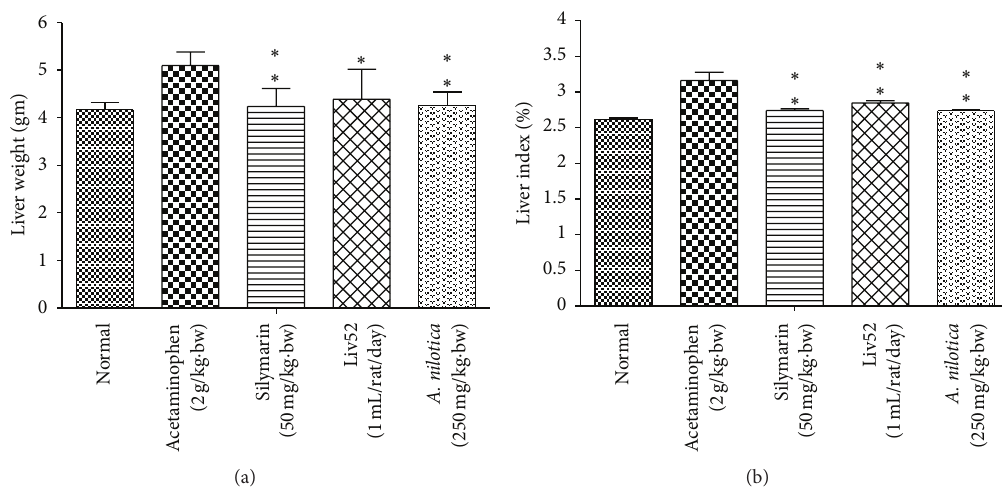
Figure 3: Effect of the methanolic extract of A. nilotica (250 mg/kg ⋅ bw) on liver weight (gm) and liver index (%) in acetaminophen-treated animals. Values are significantly different from acetaminophen treated (nonextract-treated) control, ( ∗ 𝑃 < 0.05 , ∗∗ 𝑃 < 0.01 ). 00.511.522.533.544.55